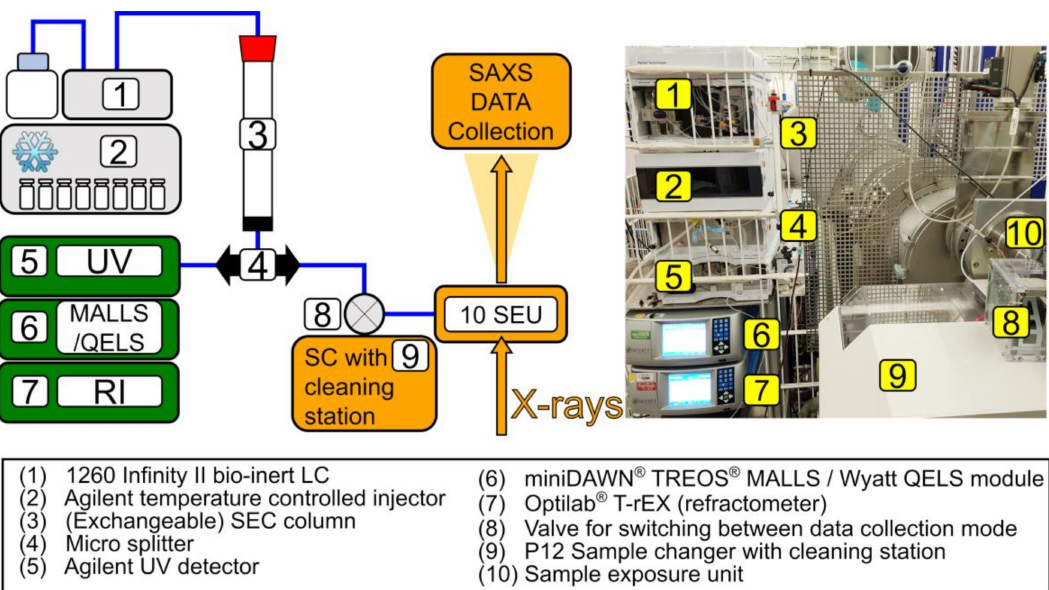
Figure 1. Size-exclusion chromatography small angle X-ray scattering (SEC-SAXS) / multi-angle laser light scattering (MALLS) station at European Molecular Biology Laboratory (EMBL)s 12 beamline (PETRA III @ DESY, Hamburg, Germany. Left, schematic drawing. Right, photograph. Individual modules are